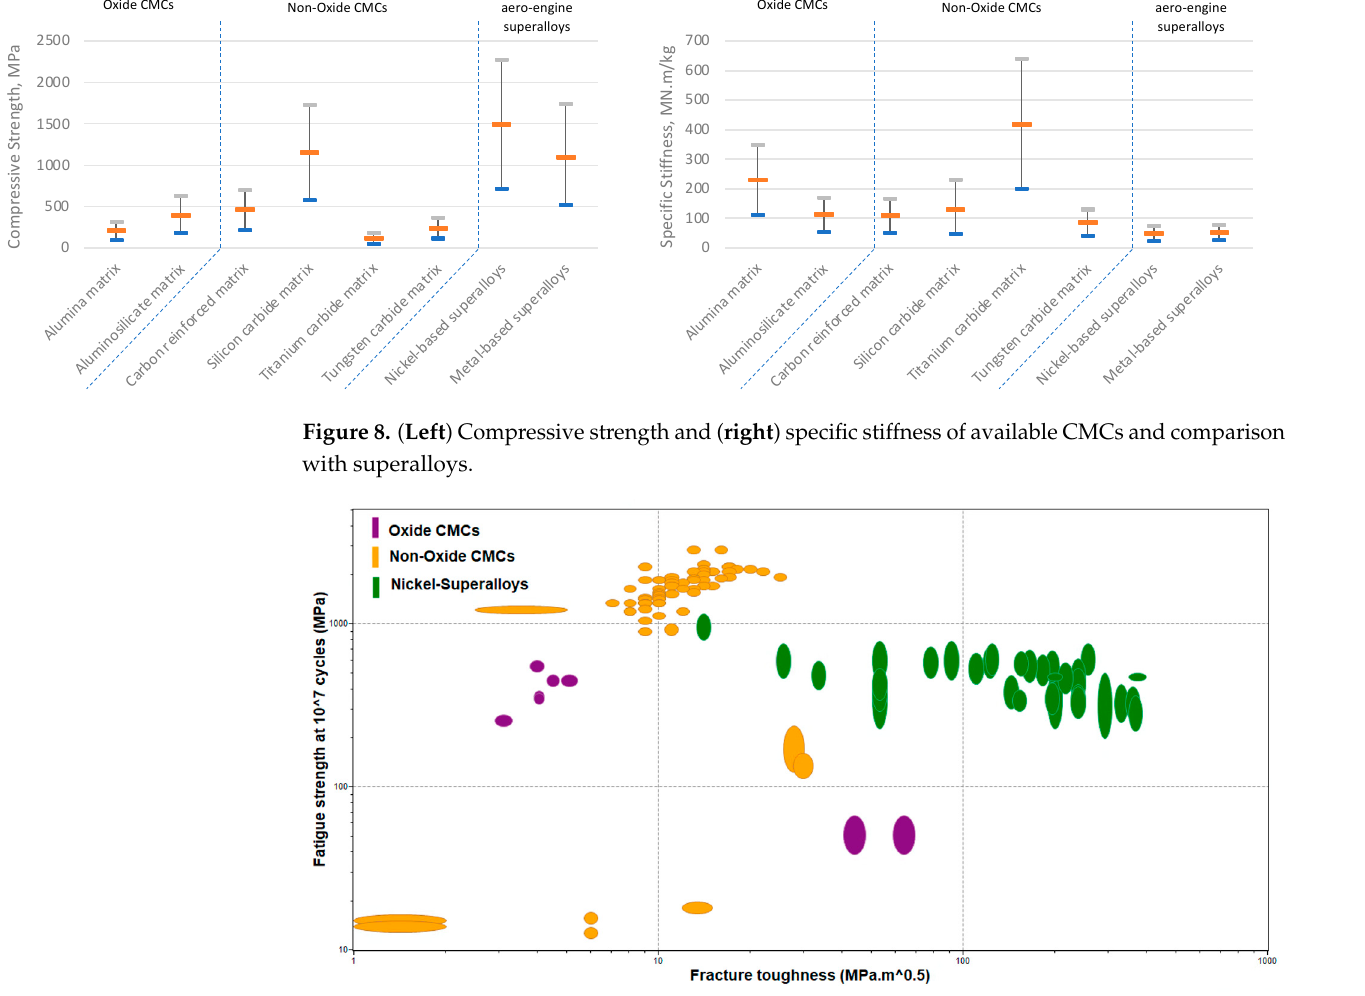
Figure 8. ( Left ) Compressive strength and ( right ) specific stiffness of available CMCs and compari- son with superalloys.